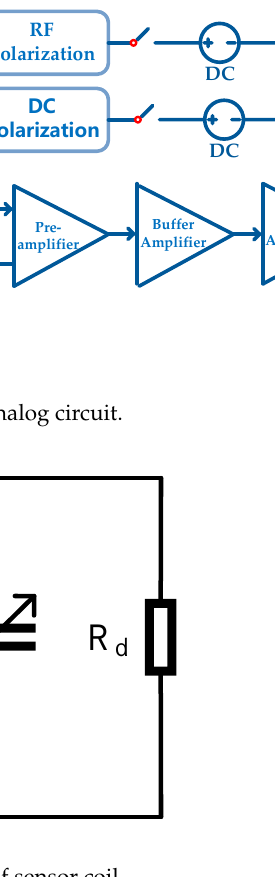
Figure 11. Equivalent circuit of sensor coil.